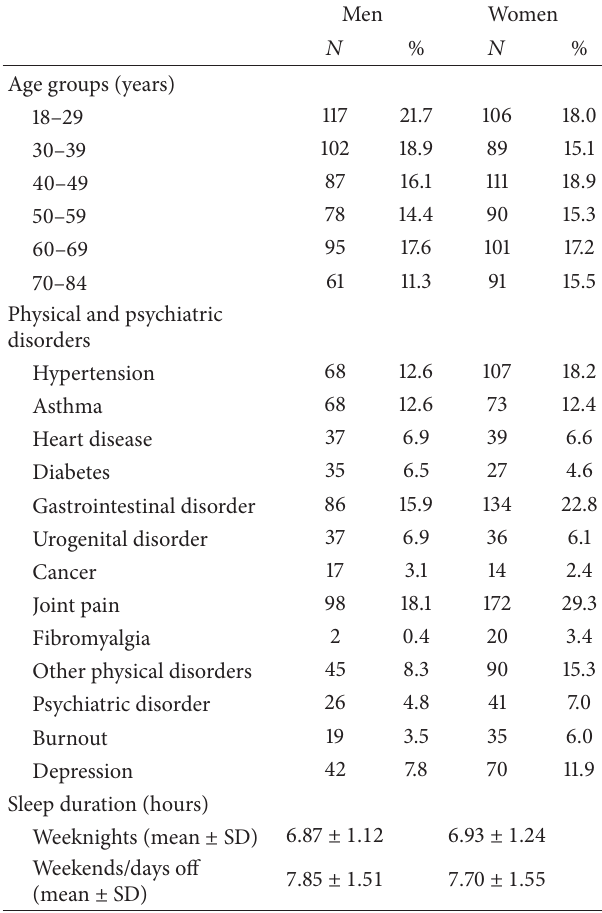
Table 1: Characteristics of the sample ( 𝑁 = 1128